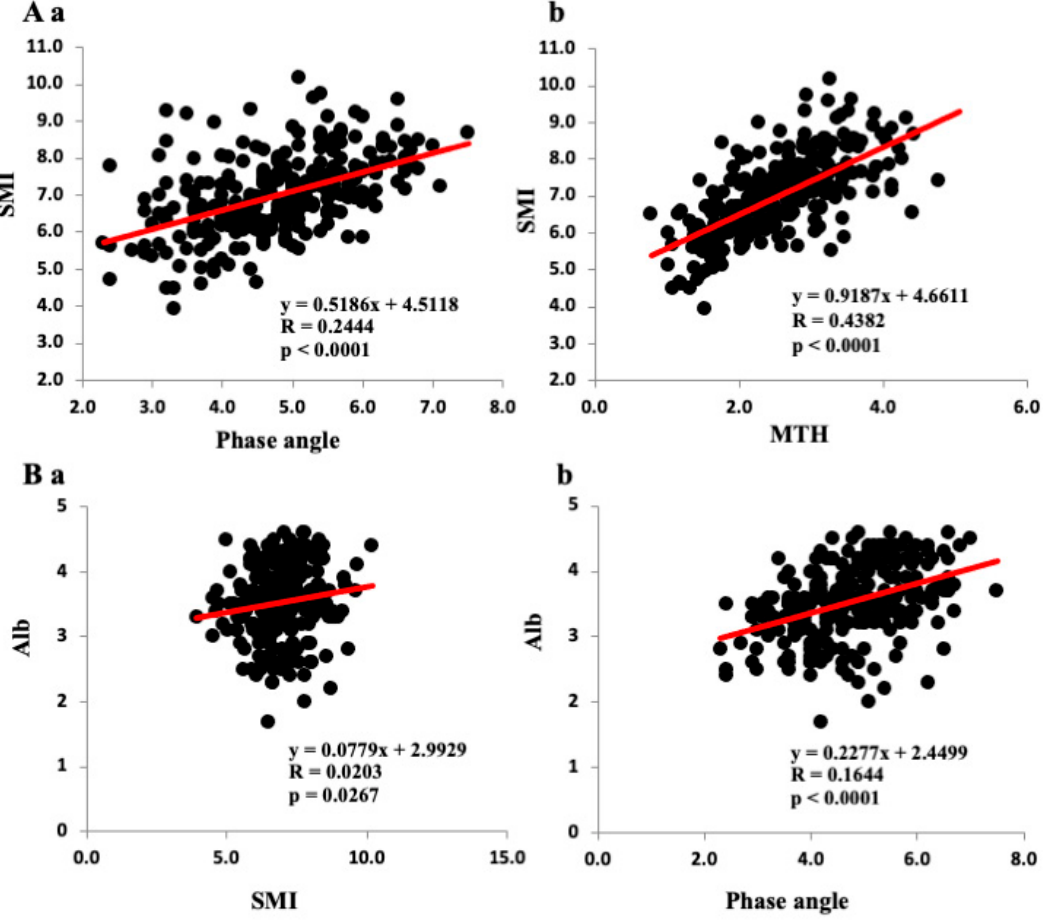
Figure 1. Relationships among the phase angle, SMI, and clinical data. ( A ): Relationships among the SMI, phase angle ( Aa ) and anterior thigh muscle thickness MTH ( Ab ) in all patients. ( B ): Relationships among albumin (Alb) level, the SMI ( Ba ), and the phase angle ( Bb ). The CONUT score correlated negatively with the PhA ( r = − 0.4190, p < 0.0001), SMI ( r = − 0.2088,